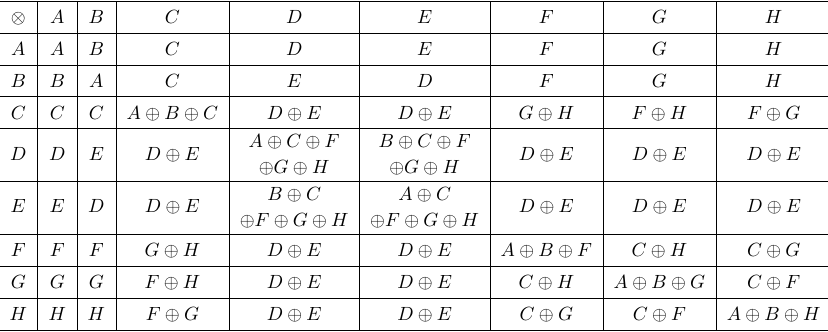
Table 3 . Fusion table of D ( S 3 )